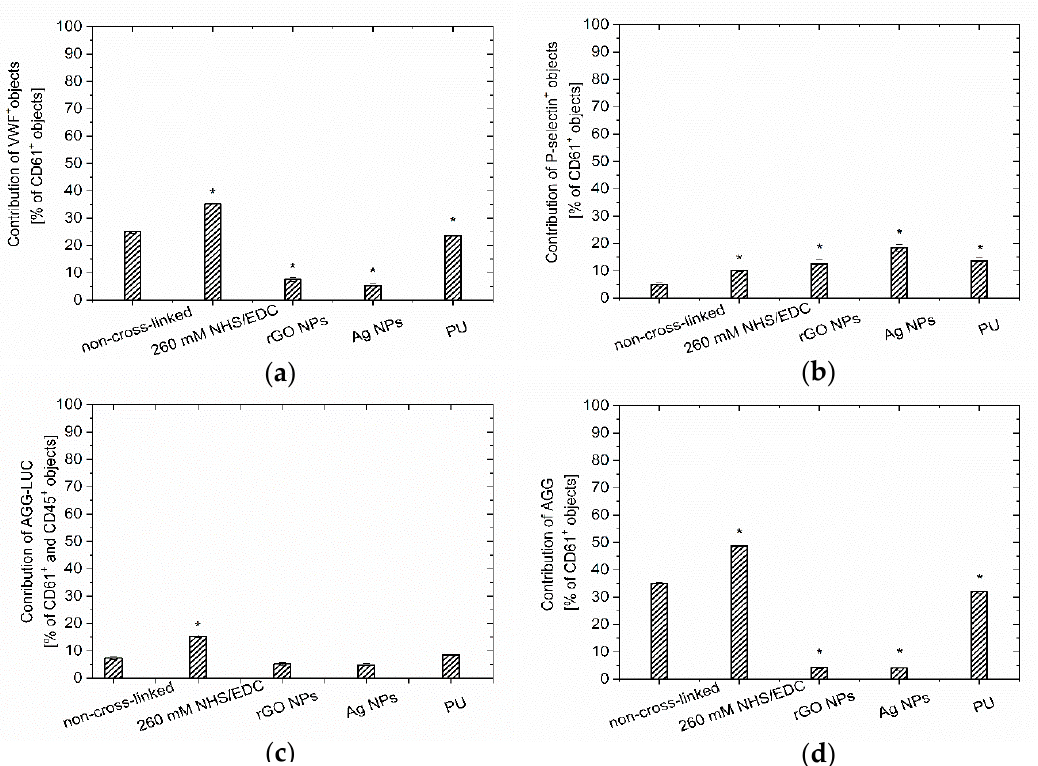
Figure 6. The contribution of ( a ) vWF positive objects; ( b ) P-selectin positive platelets; ( c ) AGG-LUC platelet-leukocyte aggregates, and ( d ) AGG platelet aggregates on the surface of unmodified Chi / CS film, cross-linked with 260 mM NHS / EDC and modified by graphene flakes and silver nanoparticles. Data represent mean ± SD, n = 8; * p < 0.05 vs. non-cross-linked sample.